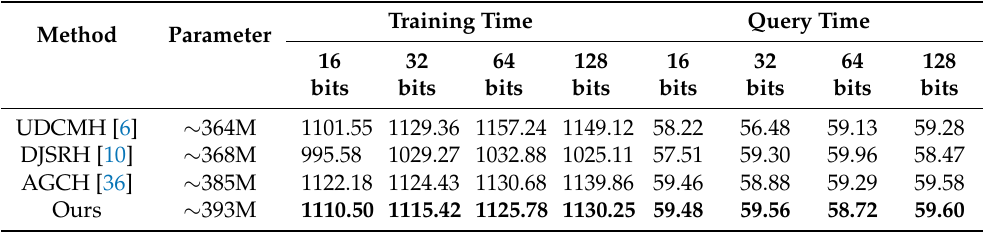
Table 7. Computational complexity and time cost (in seconds) of various models on MIRFLICKR-25K.